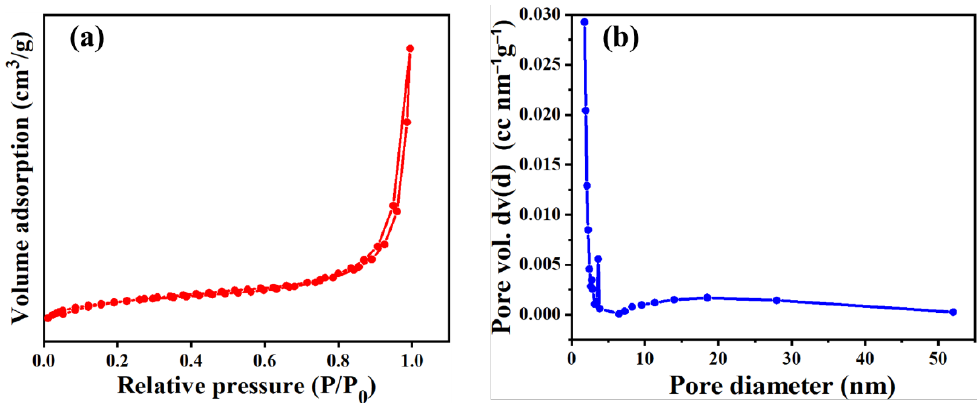
Figure 5. ( a ) The N 2 adsorption – desorption isotherms and ( b ) pore size distribution of TPC-S.